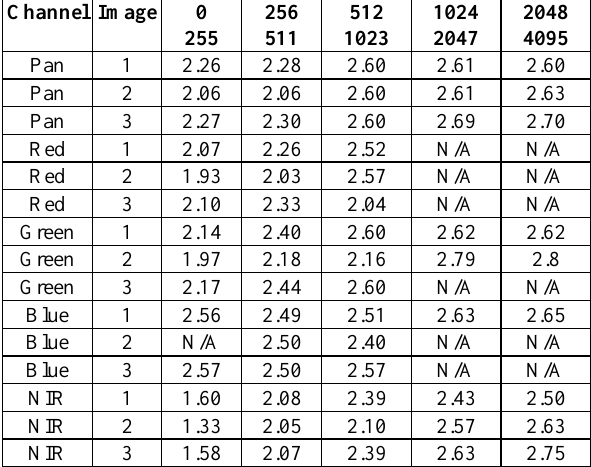
Table 2. Noise estimation values for each bin of panchromatic and multispectral bands of Pleiades triplet.